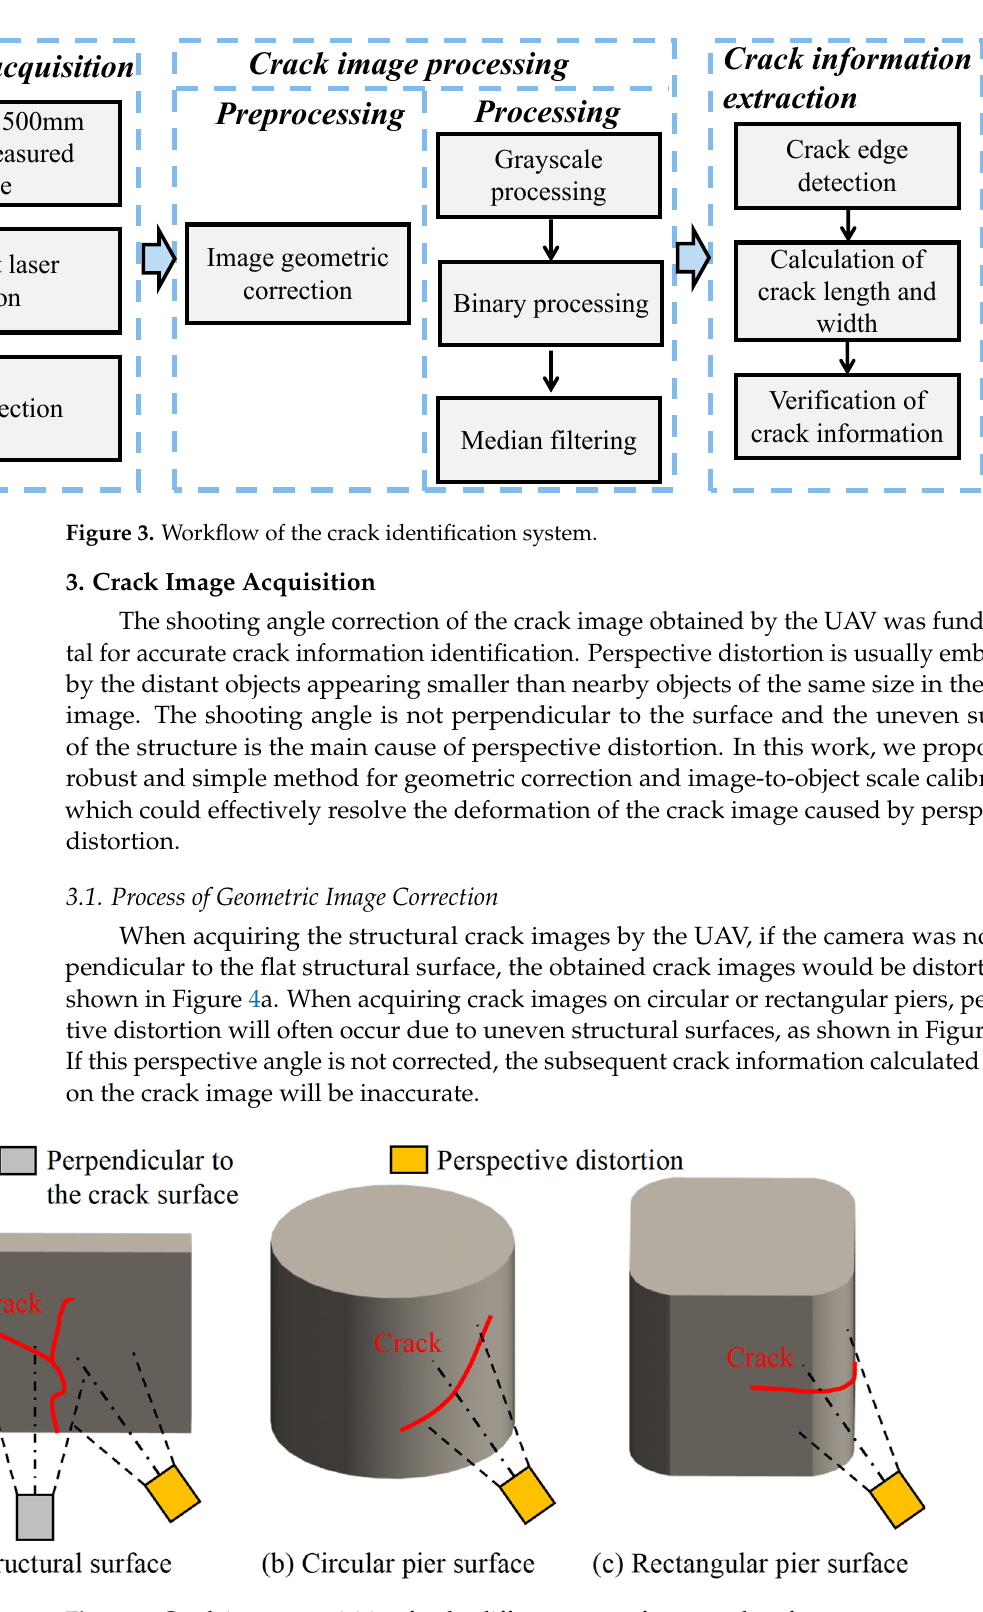
Figure 4. Crack image acquisition for the different types of structural surfaces.